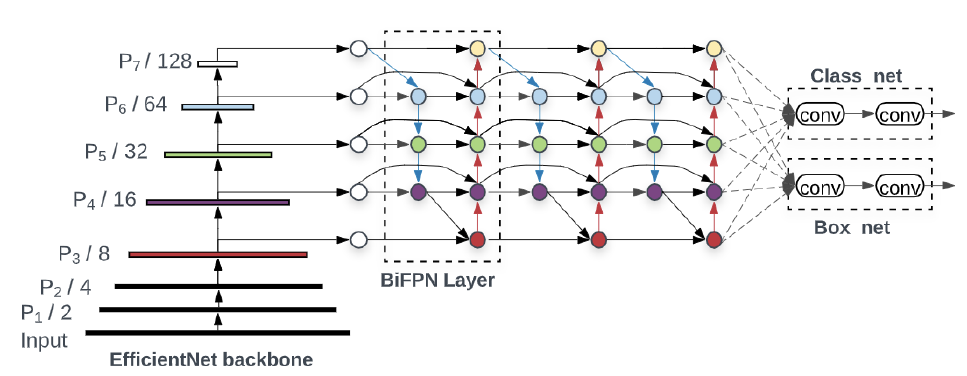
Figure A3. EfficientDet architecture. Source: [16], used with permission.